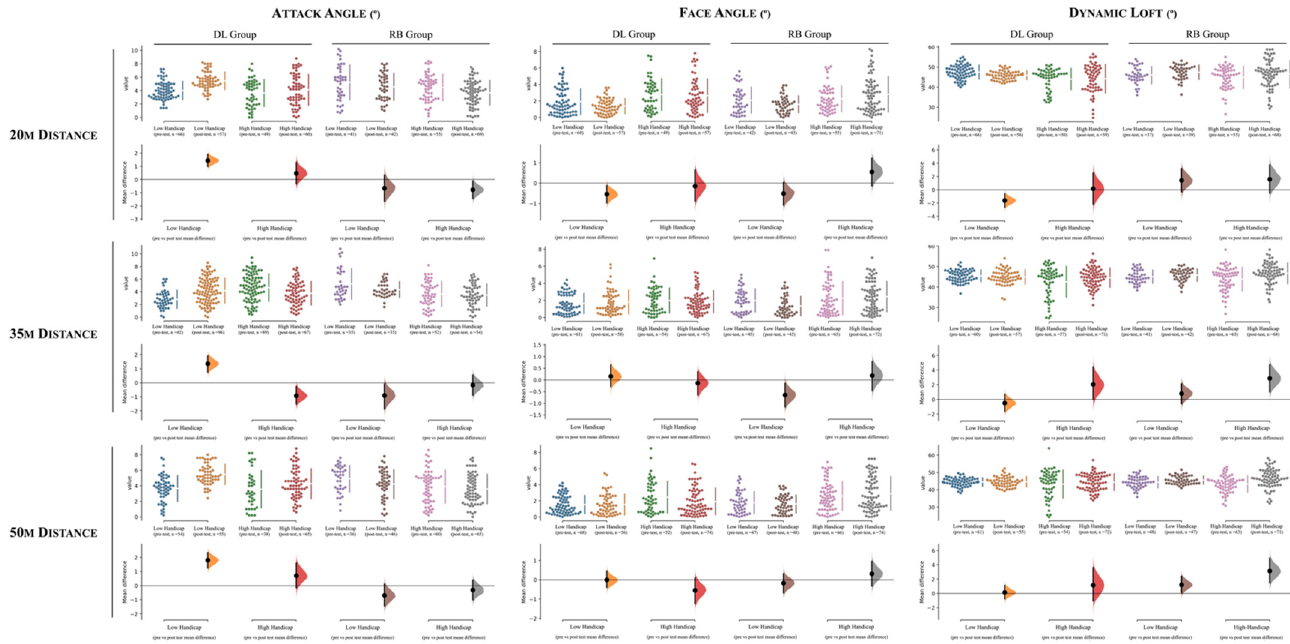
Figure 5. The Cumming estimation plot of the mean difference for 4 comparisons according to: (i) the attack angle, face angle and dynamic loft; and to (ii) distances (20 m, 35 m and 50 m). The raw data is plotted on the upper axes; each mean difference is plotted on the lower axes as a bootstrap sampling distribution. Mean differences are depicted as dots; 95% confidence intervals are indicated by the ends of the vertical error bars [45]. DL = differential learning; RB = repetitive-based.